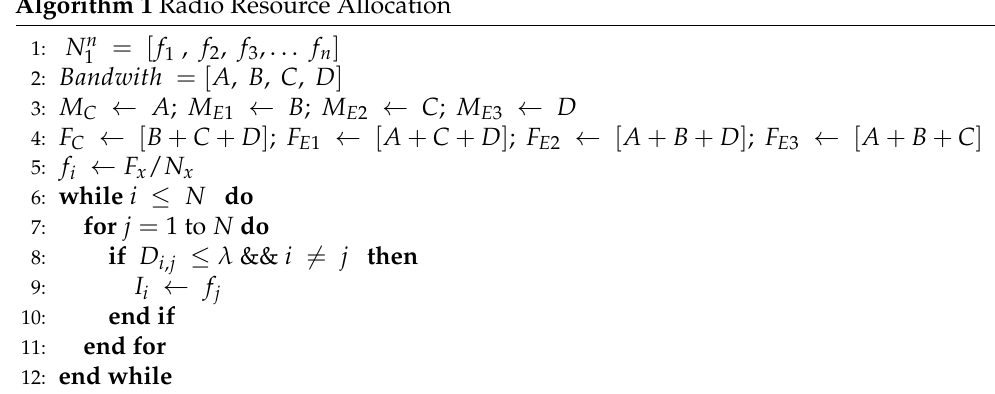
Figure 2. Channel with Max Tx power and adjustable Tx power. Algorithm 1 Radio Resource